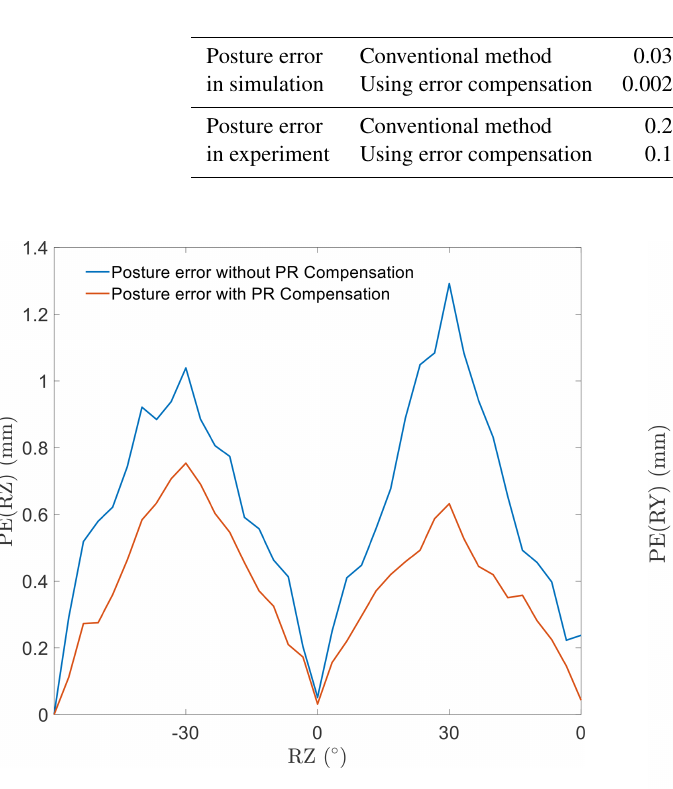
Figure 13. Comparison of posture errors in rotational motion around z axis. Figure 14. Comparison of posture errors in rotational motion around y